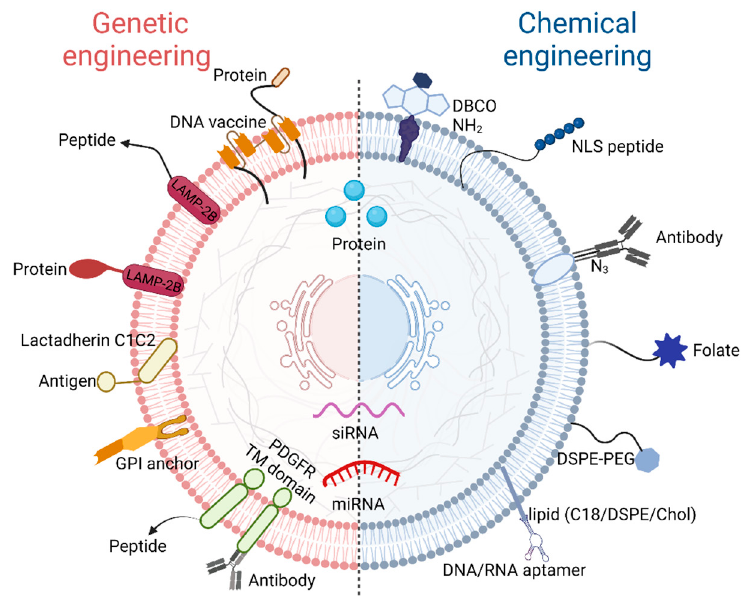
Figure 4. Modify exosomes via genetic and chemical engineering. Genetic engineering introduces proteins and peptides through the genetic fusion of membrane proteins. Chemical engineering introduces lipids, peptides, proteins, small molecules, and polymers through the chemical reactions between lipids and proteins or lipids and lipids.